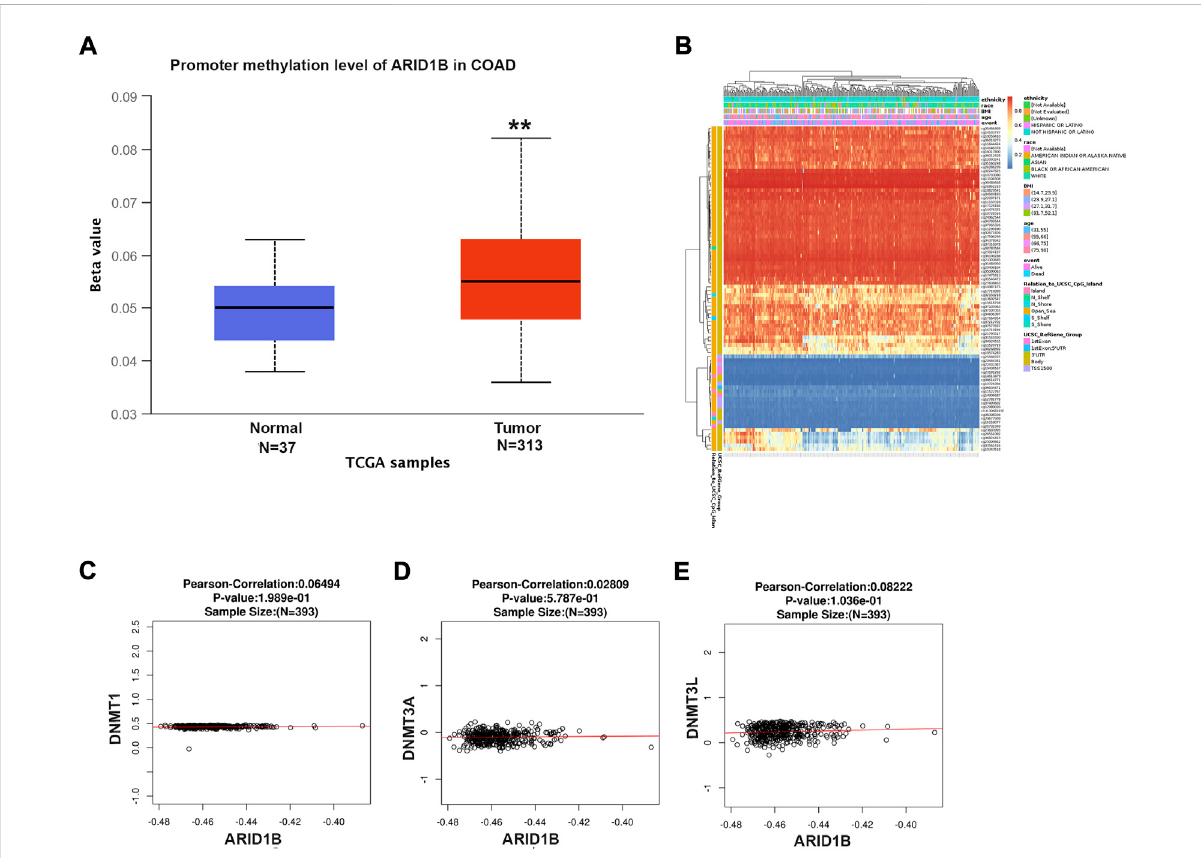
FIGURE 2 ARID1B methylation level analysis. (A) ARID1B methylation level from UALCAN (B) Different CpG probs of ARID1B from Methsurv (C – E) The positivecorrelationofARID1Bandmethyltransferases.N,Normal;T,Tumor;S,Stage;Cau,Caucasian;Afr-Amr,African,American;Asi,Asian;M,Male, F, Female; y, year; N-W, Normal Wight; E-W, Extreme Wight; Ob, Obese; E-B, Extreme Obese; Ad, Adenocarcinoma; Muc, Mucinous Adenocarcinoma.